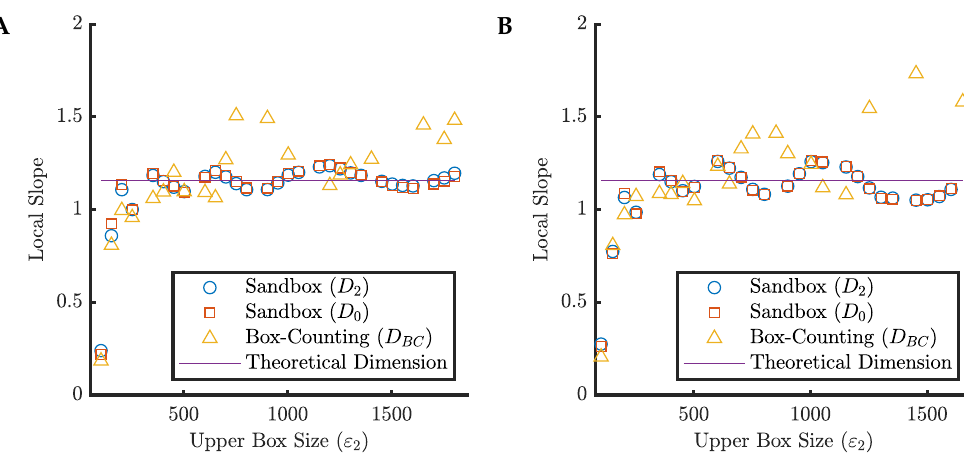
Figure 10. Plots showing the local slopes as a function of the upper box size ε 2 for two statistically self- similar fractal tree canopies. ( A ) r ∼ U ( 0.51,0.59 ) , θ = π